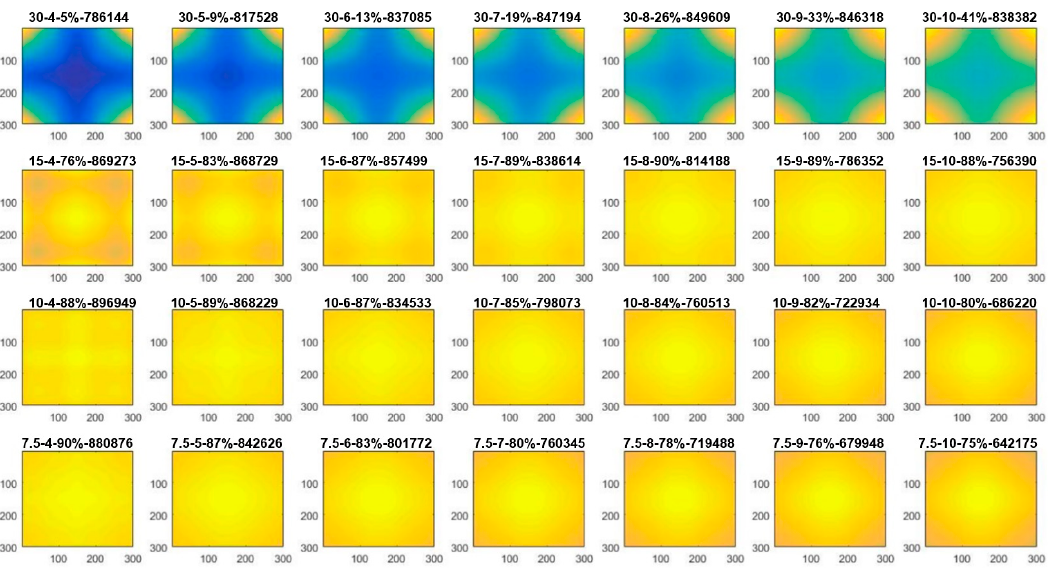
Figure 5. Array analysis of CSP.